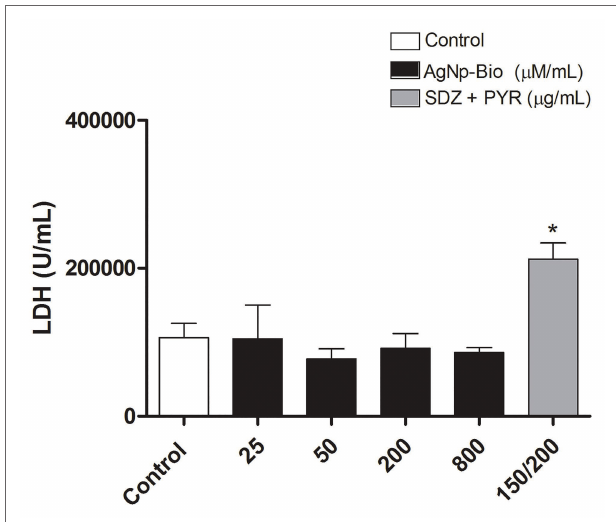
FIGURE 2 | Analysis of toxicity in human villous explants after treatment with different nanoparticles concentration. Villous explants were cultured in a period of 24 h in 96-well plates and treated with AgNp-Bio concentration ( μ M/ml) or combination of sulfadiazine/ pyrimethamine (SDZ + PYR) or complete medium (negative control). After, supernatants were collected and lactate dehydrogenase (LDH) activity was measured using the LDH Liquiform Kit. Three placentas were used, and three independent experiments were performed in five replicates. Data were expressed as mean ± SEM from three independent experiments in five replicates. Comparison in relation to negative control (medium; Control -; * p < 0.05). Differences between groups were analyzed by One-Way ANOVA with the Dunnett’s multiple comparison post hoc